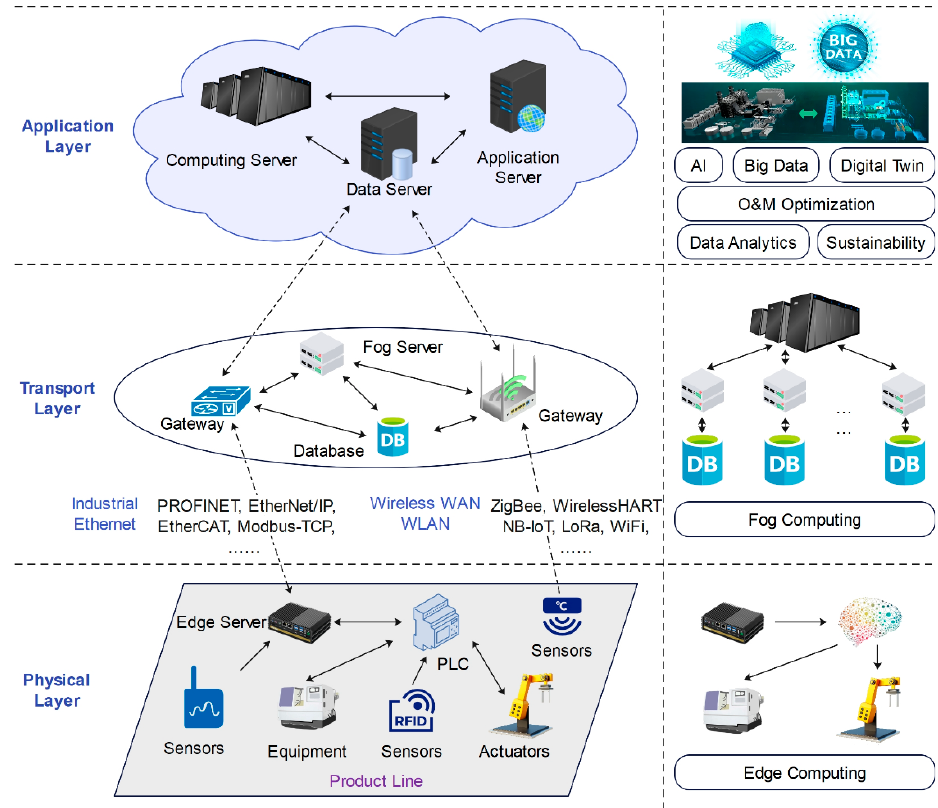
Figure 1. Reference architecture.